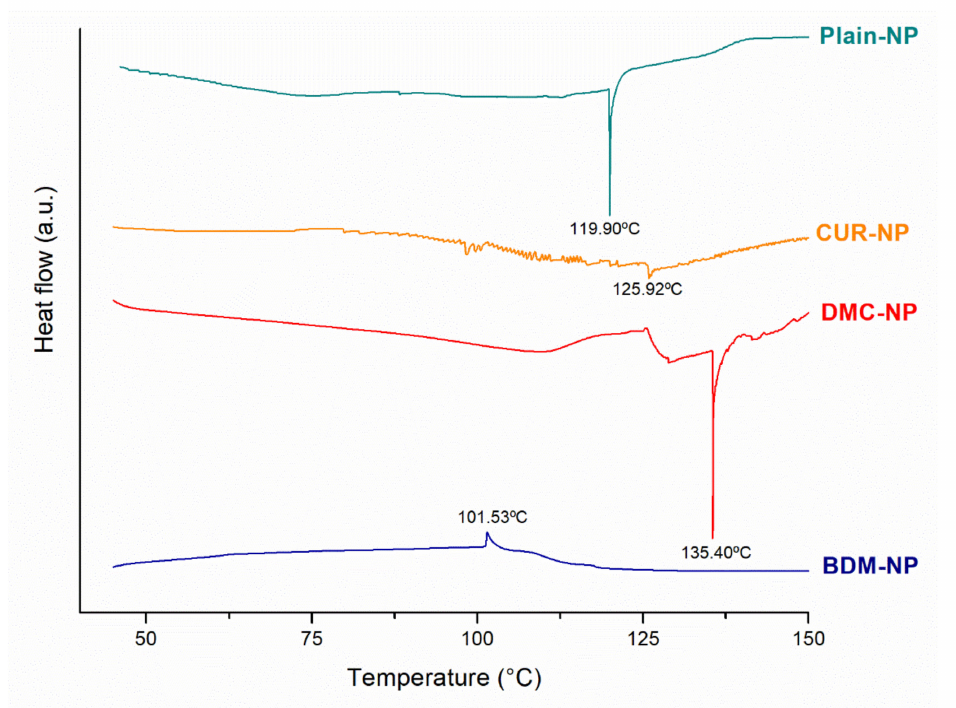
Figure 4. DSC curves of Plain NP, CUR-NP, DMC-NP, and BDM-NP